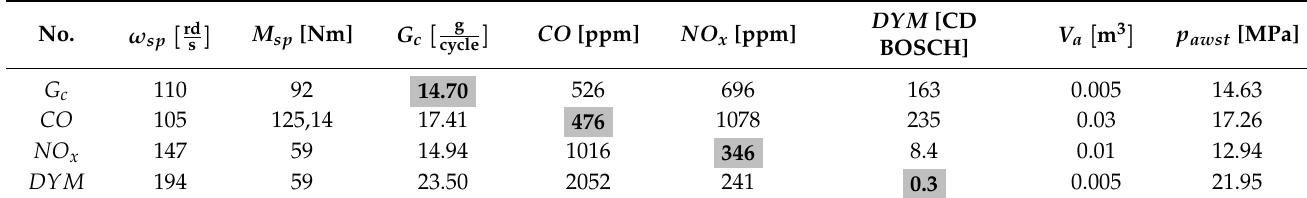
Table 13. Combustion engine duty points for various optimization criteria and load